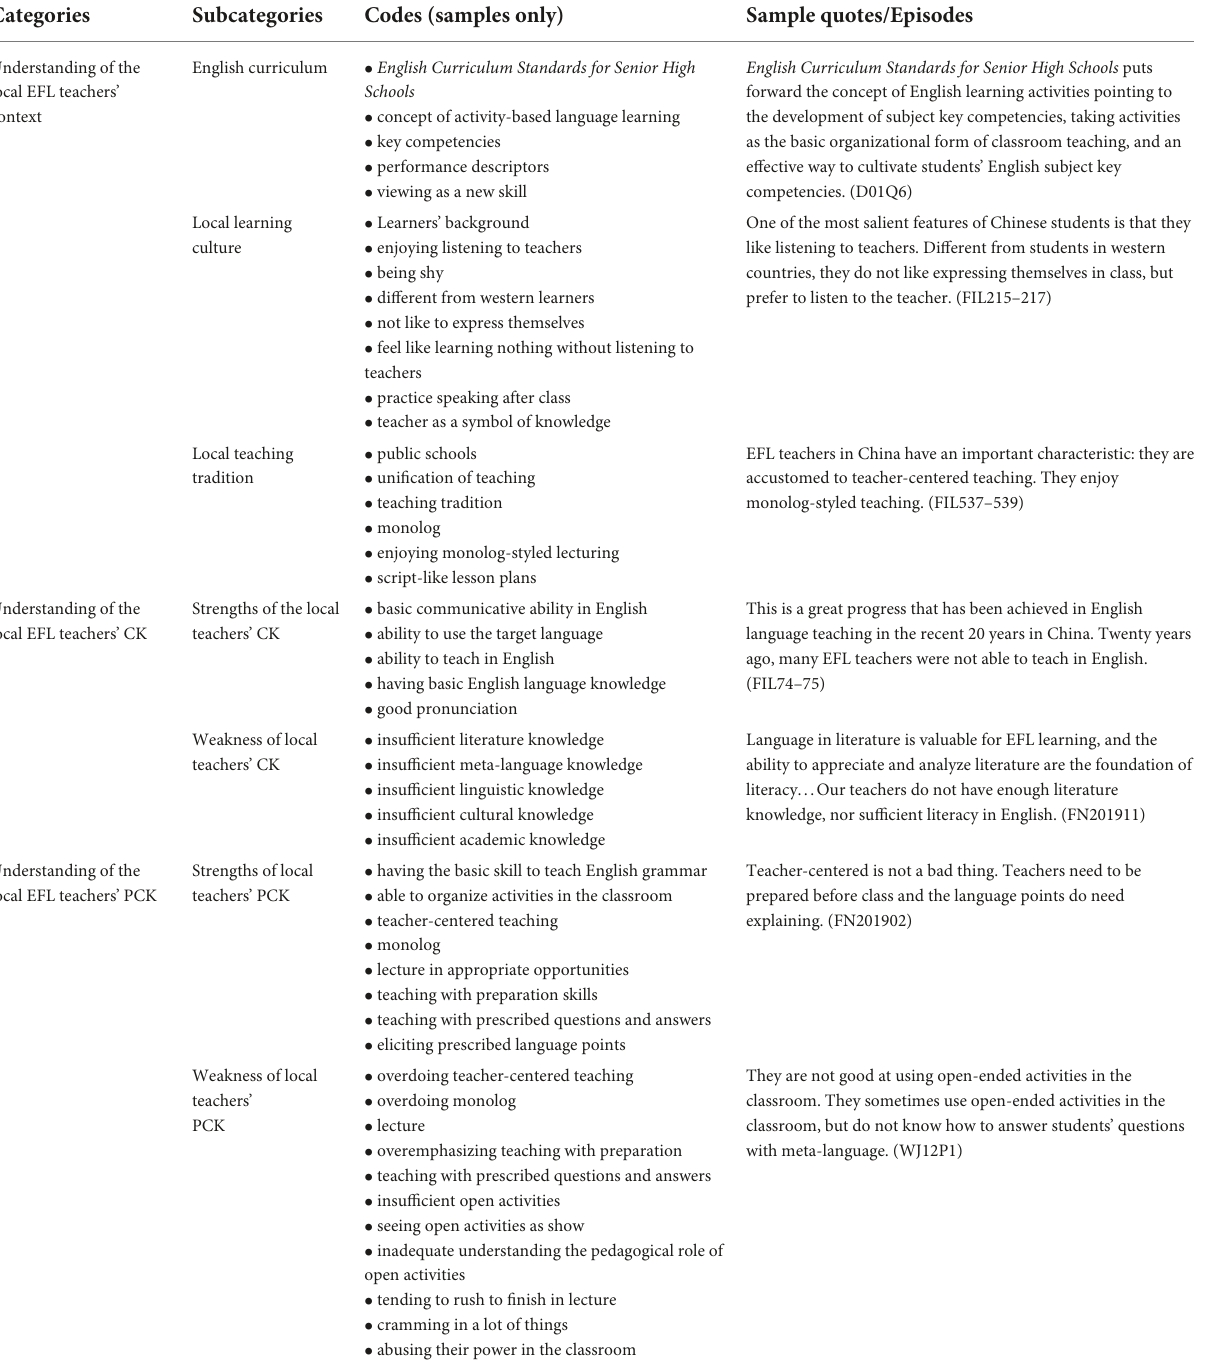
TABLE 1 Coding scheme for Chau’s understanding of local EFL